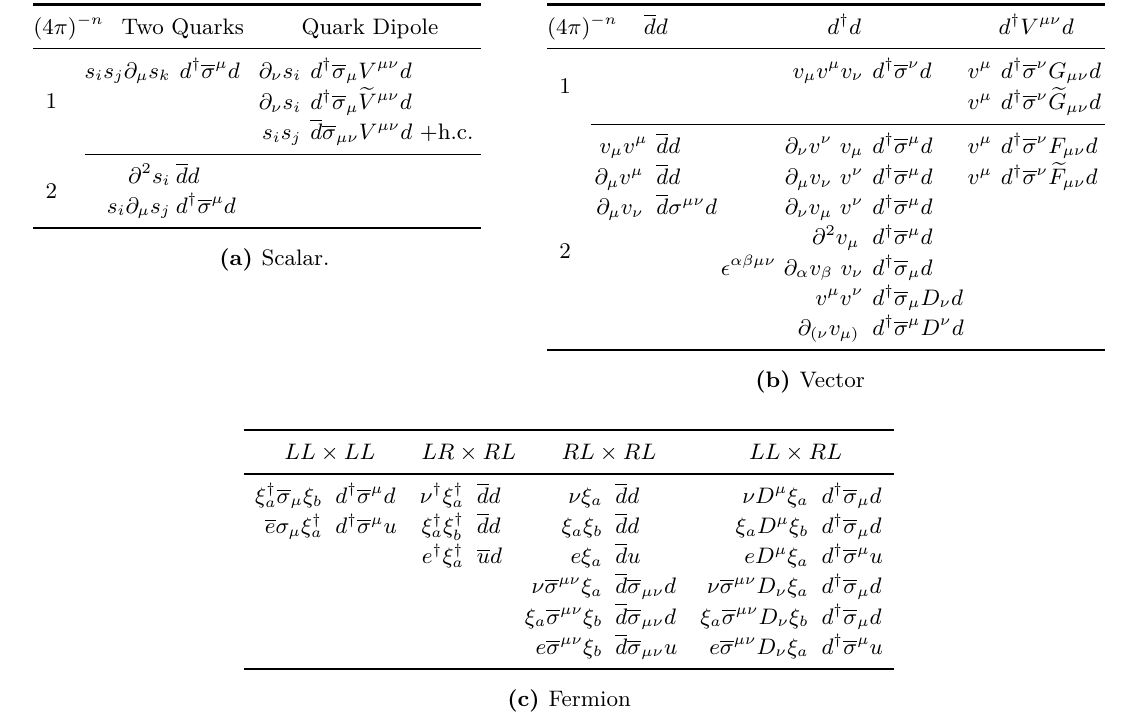
Table 5. List of all sub-leading quark-flavour changing strong scale operators up to dimension seven that couple LEFT to messenger fields of spin 0, 1 spin 0 messenger fields, panel shows c those for spin 1 spin 1 messengers. All fermionic operators are suppressed by factors of (4 π ) − 1 , and the suppression factor for the bosons are given in the tables. The notation is the same as in table 4.